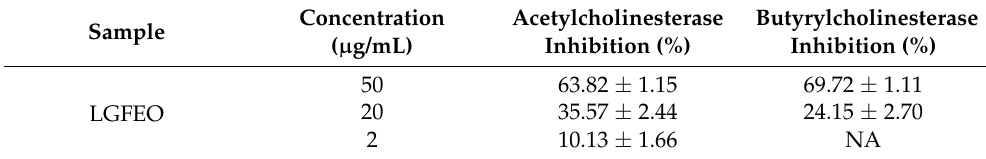
Table 4. Cholinesterase inhibitory activity of the LGFEO by inhibition percentage.